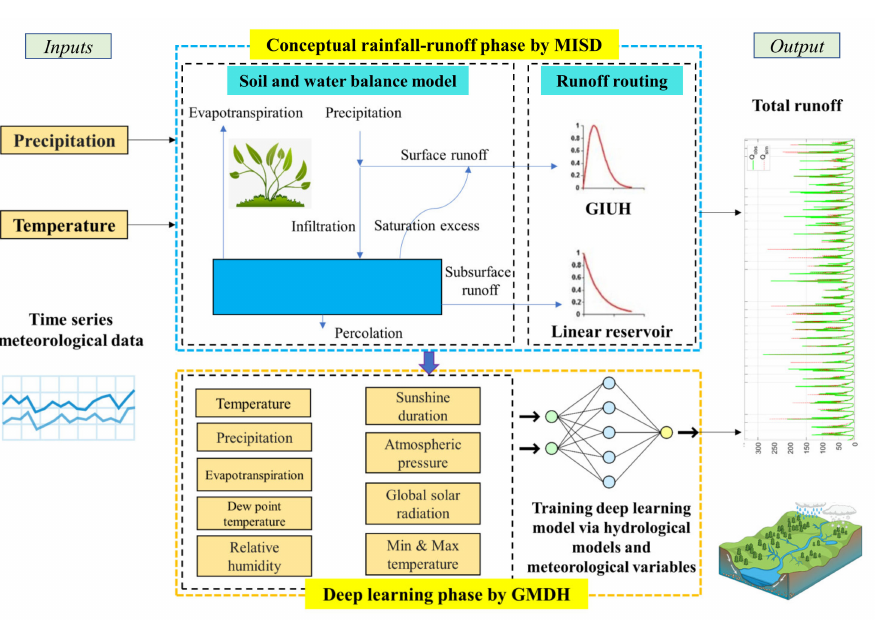
Figure 4. Flowchart of the current